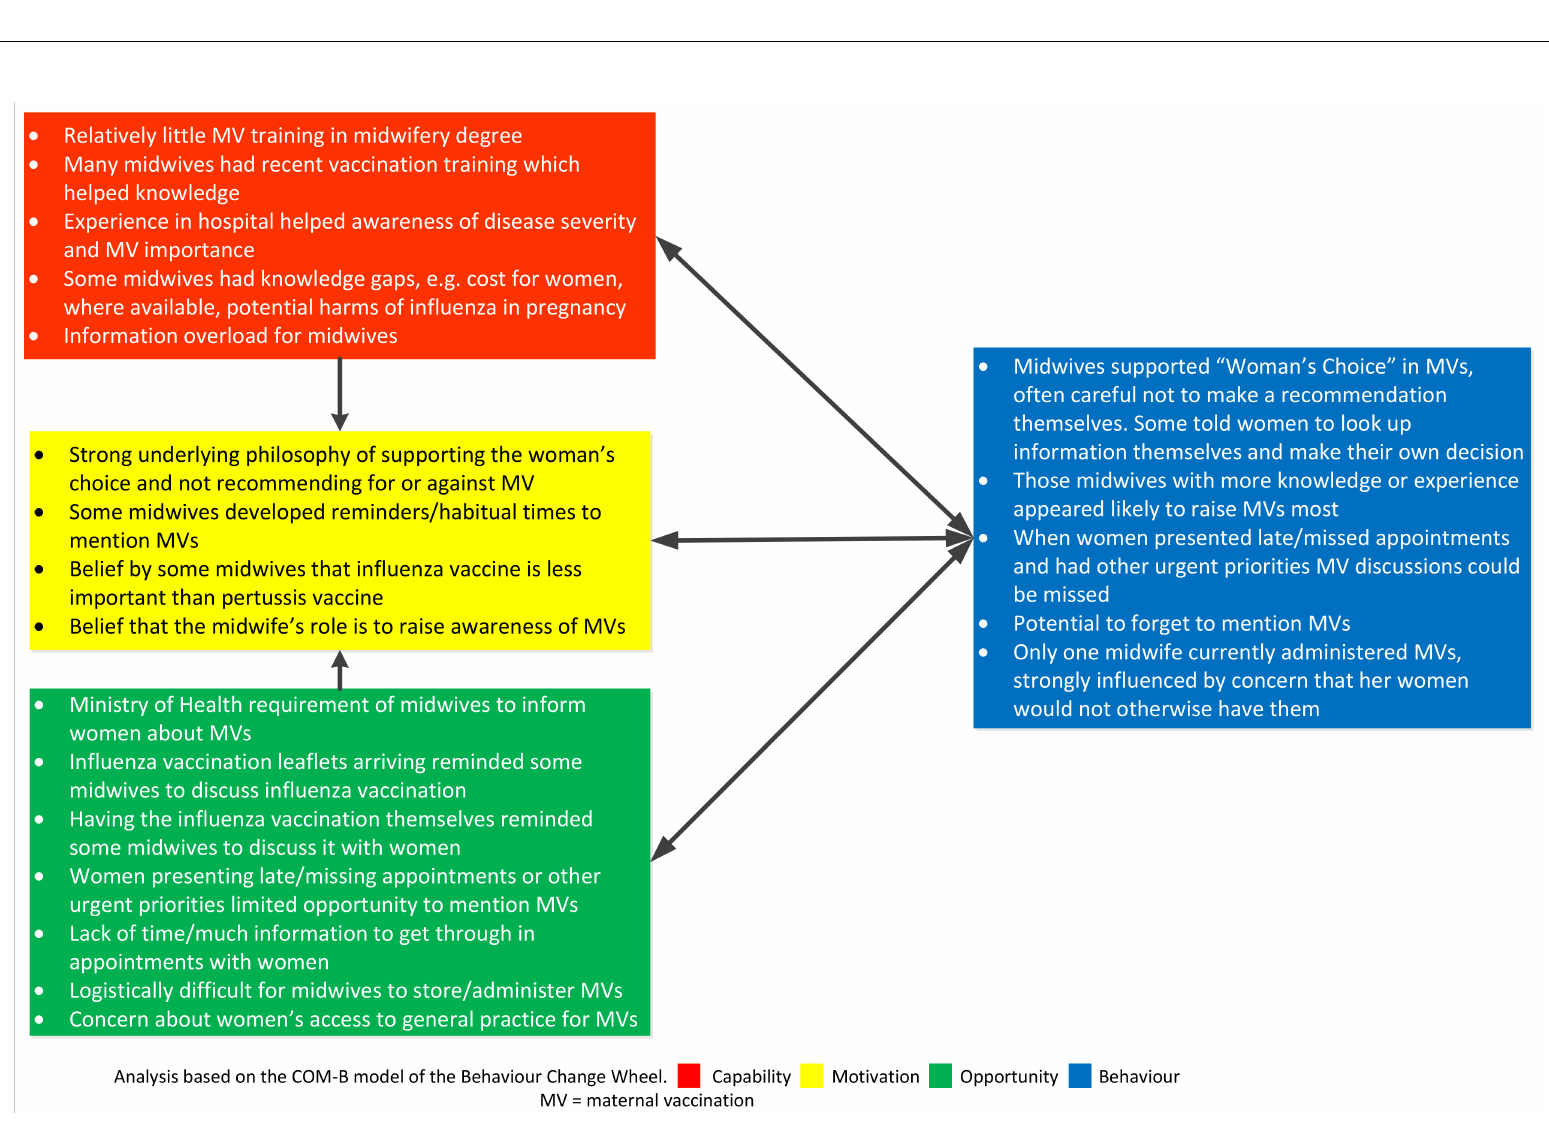
Figure 3. Factors affecting the recommendation and administration of maternal vaccines (MVs) for midwives using the COM-B